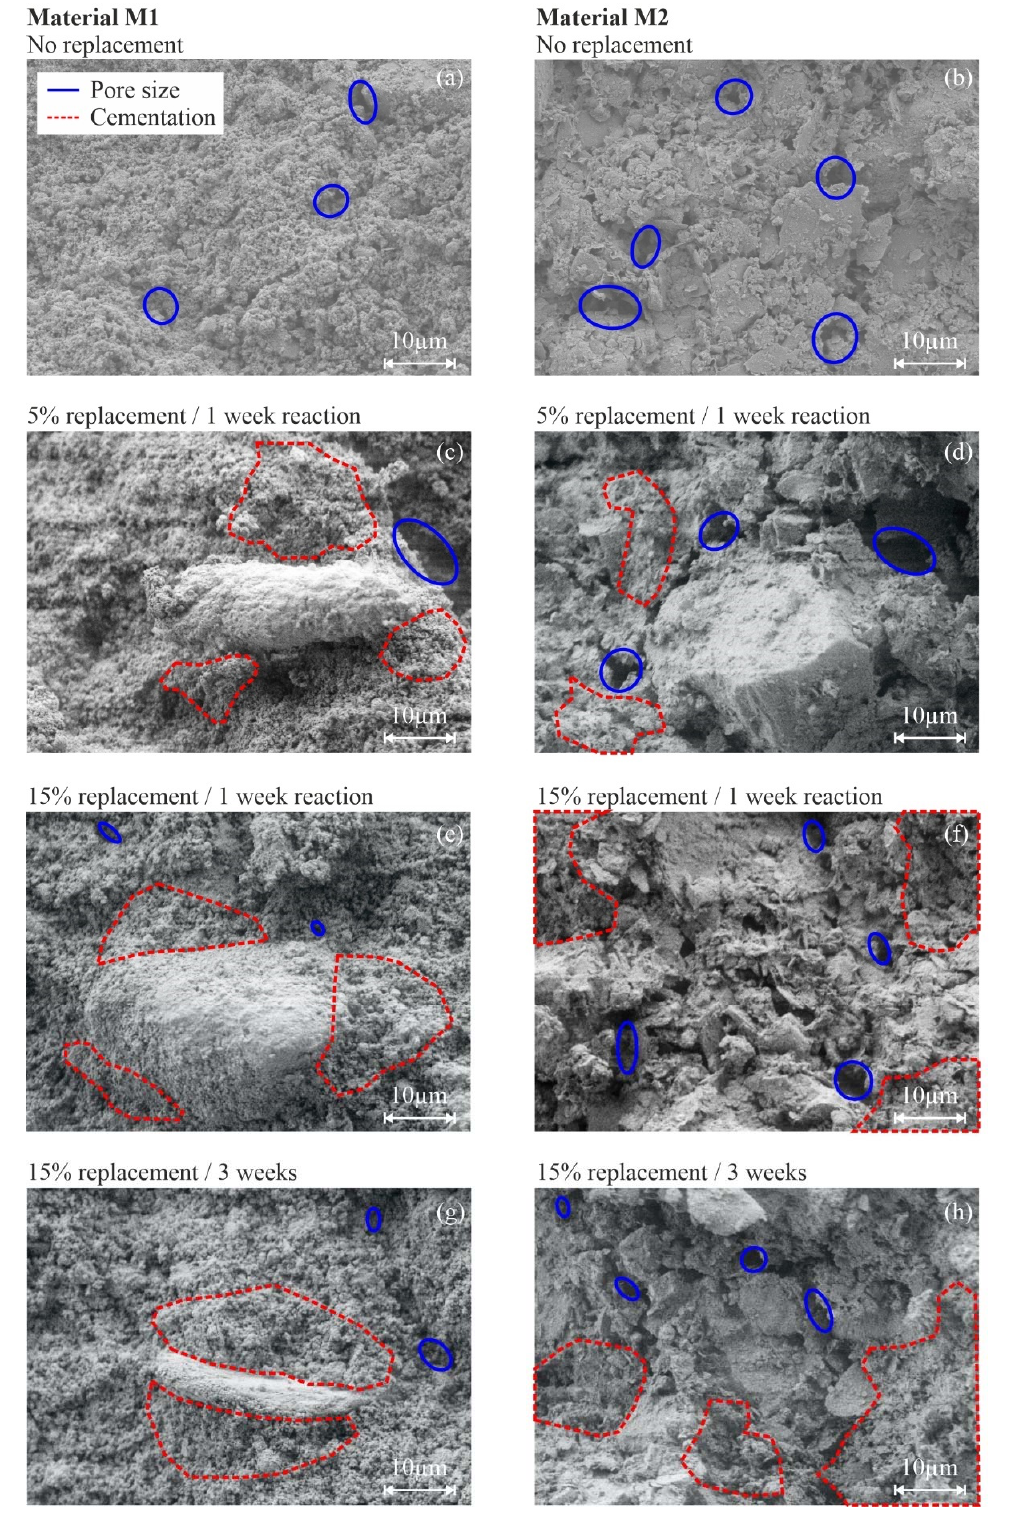
Figure 8. Scanning electron microscopy images of uncemented and artificially cemented soil speci- mens ( M1: ( a , c , e , g ) column and M2: ( b , d , f , h ) column).